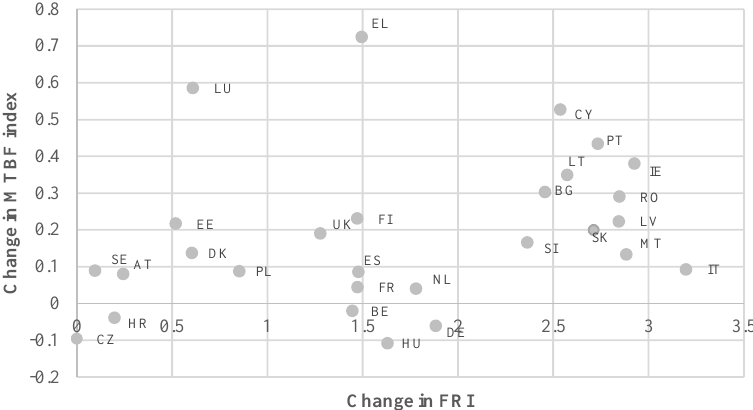
Source: own calculations based on the European Commission data (MTBF database – “new” methodology). Figure 3. Changes in the MTBFI and FRI between 2009 and 2016